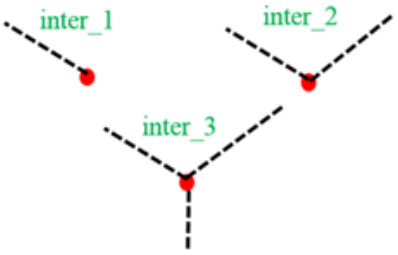
Figure 3. Examples of bike route intersection.